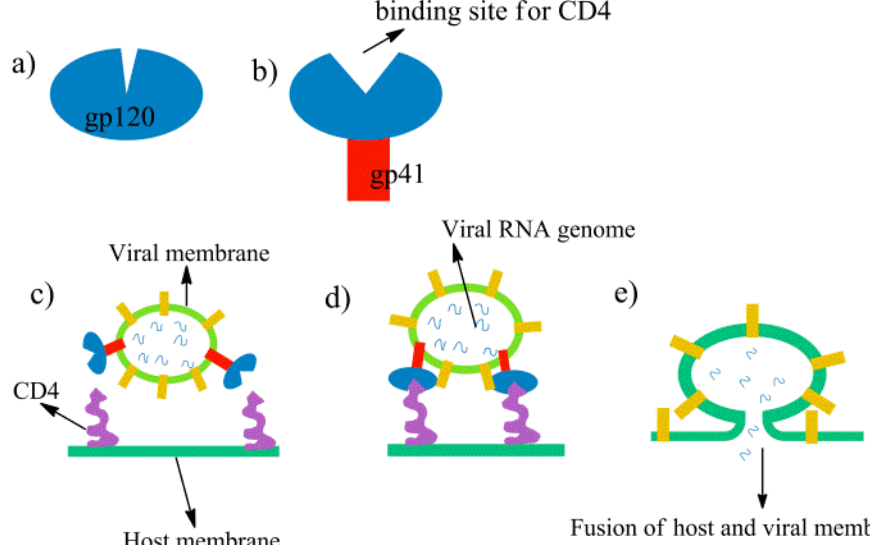
Scheme 1. A schematic representation of HIV-1 entry and fusion of virion into the host membrane. ( a ) a schematic representation gp120, ( b ) a schematic representation of gp41 binding with CD4 and ( c – e ) attachment and fusion of virus with host